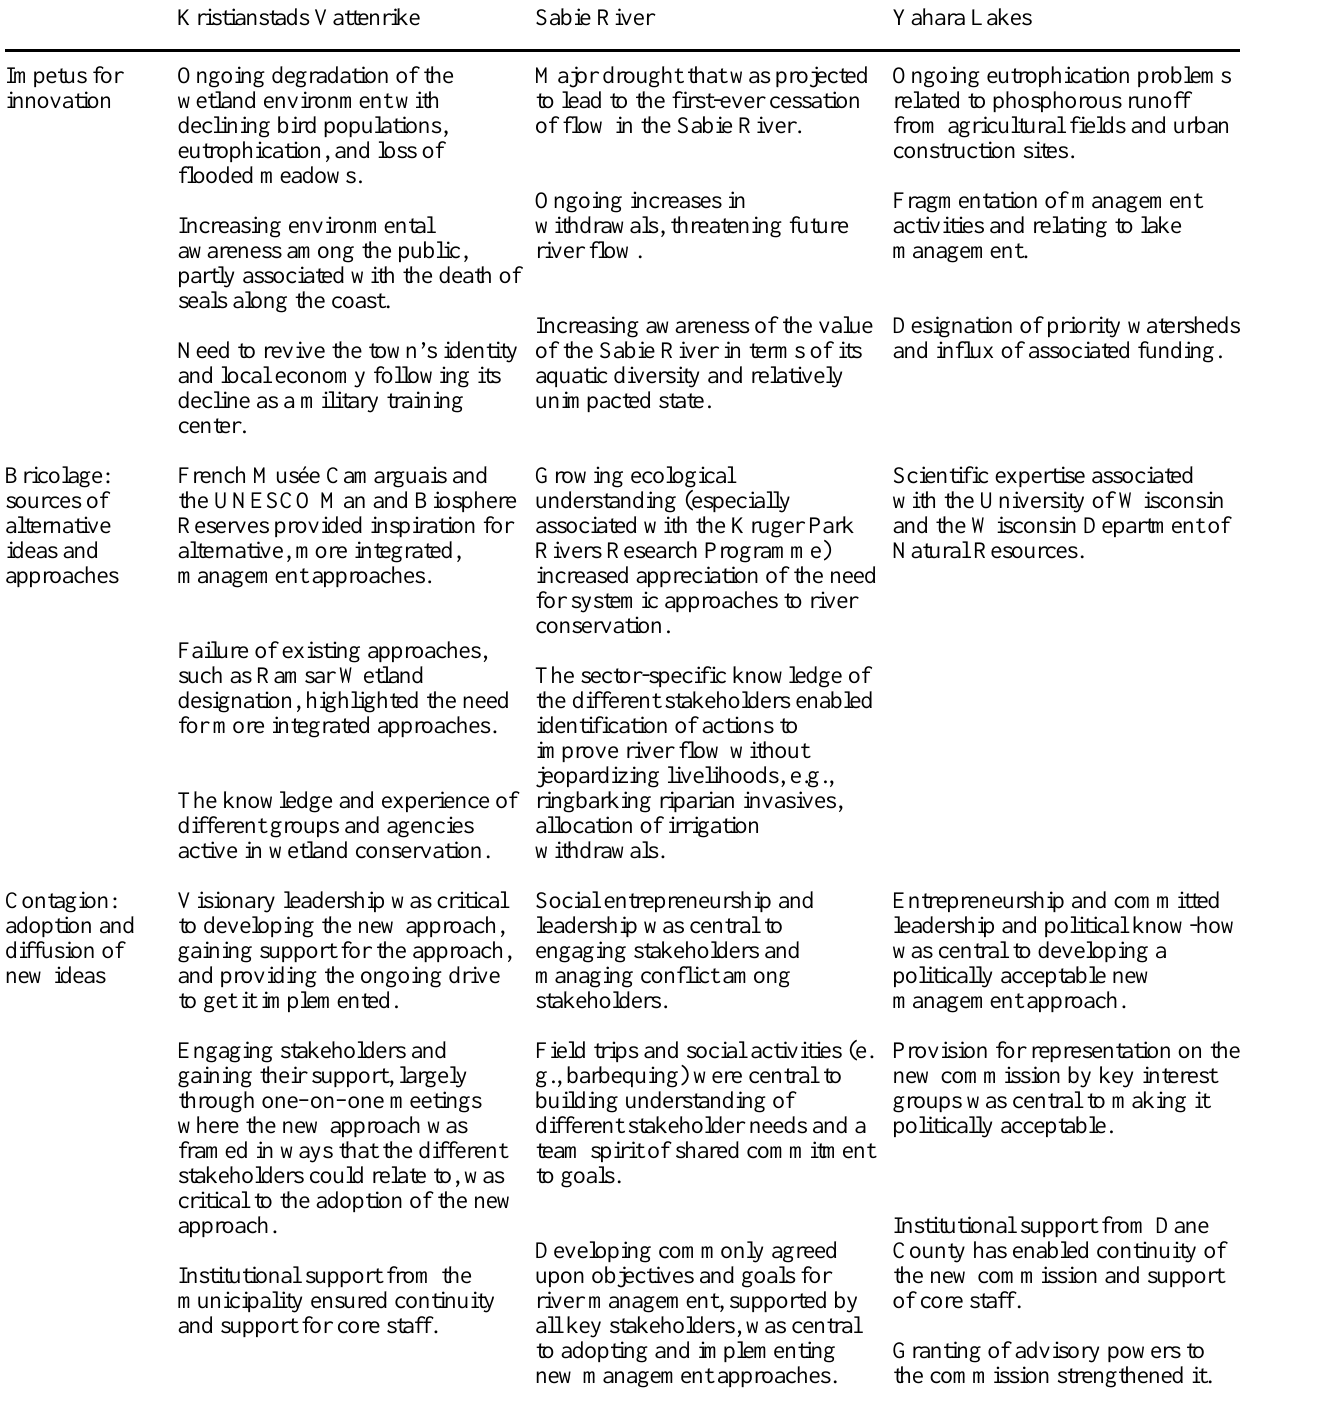
Table 2. Key factors that triggered social innovation in ecosystem management, acted as sources of ideas for alternative management approaches (bricolage), and facilitated diffusion of new approaches (contagion) in each of the case